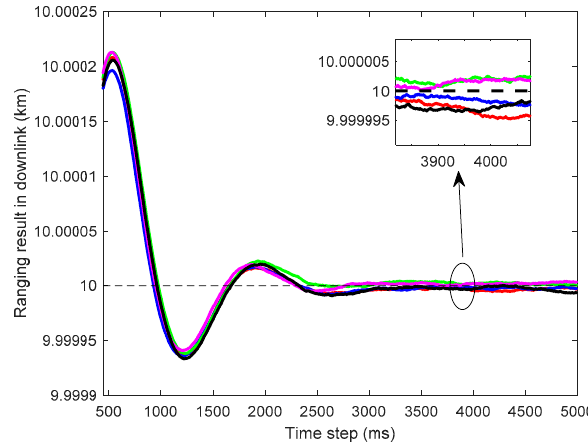
Figure 7. Repetitive experiments about ranging results in downlink.